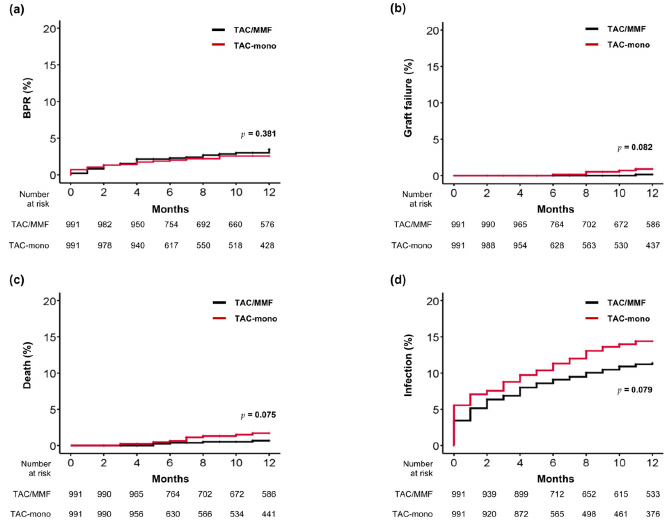
Figure 2. Comparison of outcomes between matched TAC/MMF and TAC-mono groups. ( a ) Biopsy- proven rejection, ( b ) graft failure, ( c ) death, and ( d ) infection. BPR, biopsy-proven rejection; MMF, mycophenolate mofetil; TAC, tacrolimus.